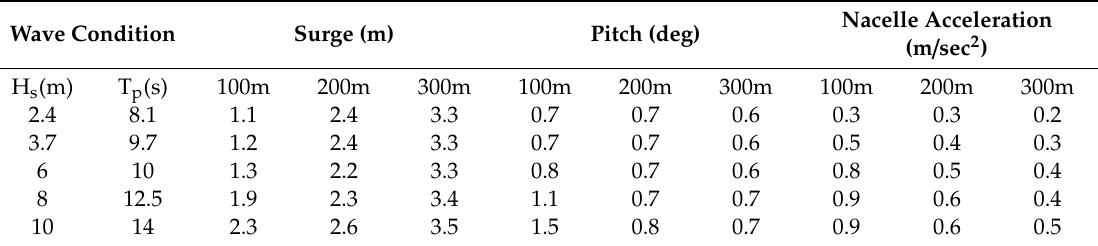
Nacelle Acceleration (m / sec 2 )